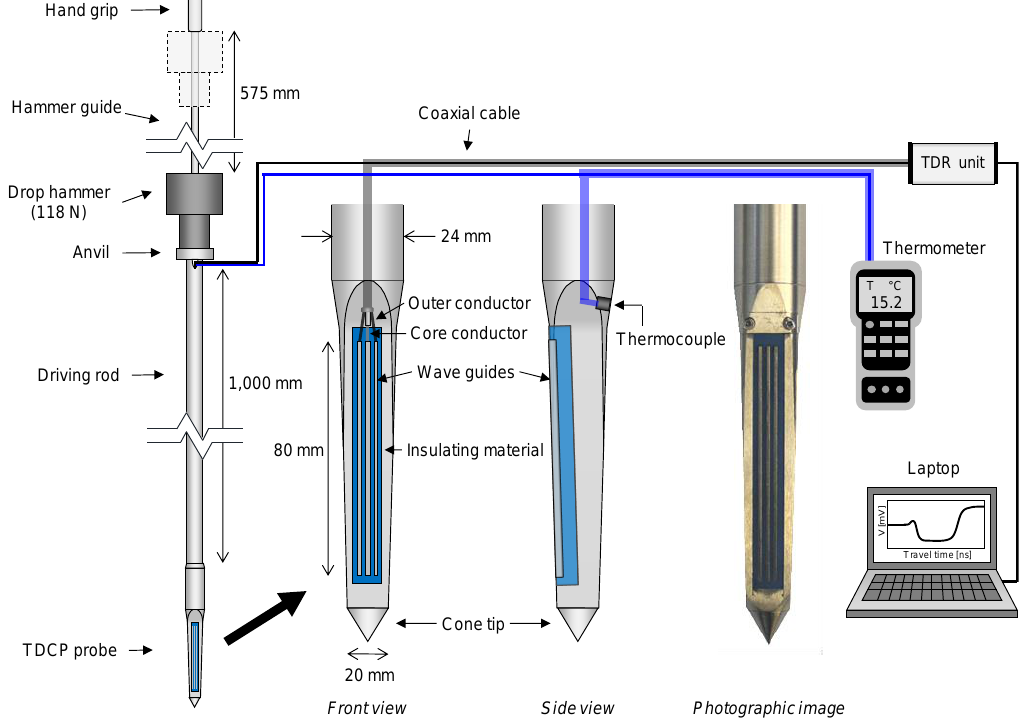
Figure 3. Dynamic cone penetrometer incorporated with TDR sensors (TDCP).